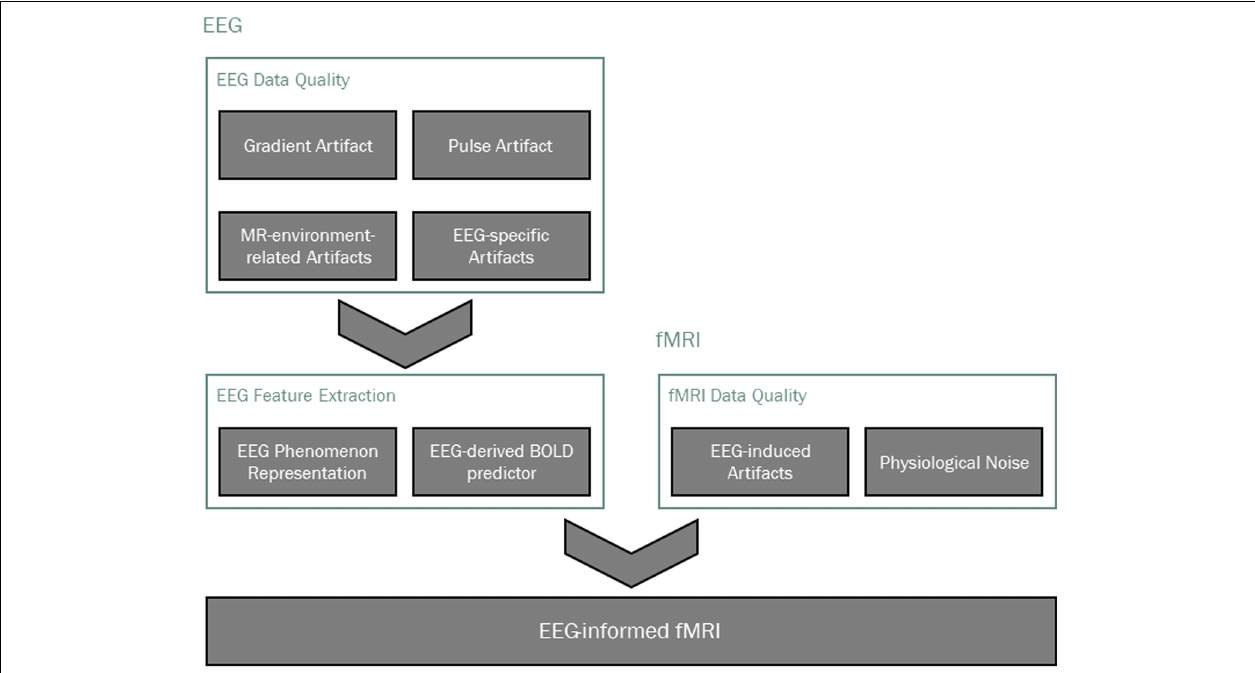
FIGURE 1 | Main processing pipeline steps in EEG-informed fMRI analysis. Data quality is typically addressed first, taking into account modality-specific artifacts, as well as those that are induced by one technique on the other. The EEG phenomenon of interest is then identified and appropriate features are extracted, from which a BOLD signal predictor is derived for the localization of EEG-related BOLD-fMRI